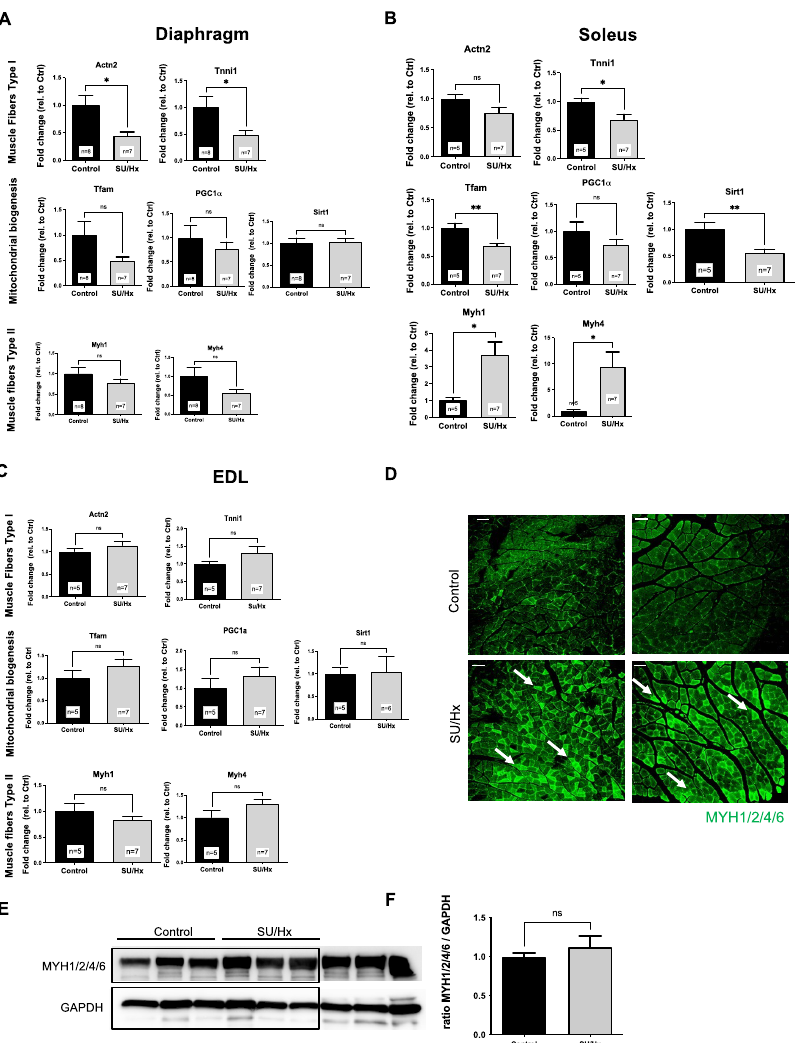
Figure 2. ( A ) Decreased abundance of Type I markers ( Actn2 and Tnni1 ) and markers of mitochondrial biogenesis ( Tfam and PGC-1 α ) in diaphragms from animals with SU/Hx-induced PH when compared to those of the controls. ( B ) Decreased abundance of Type I markers ( Actn2 and Tnni1 ) and markers of mitochondrial biogenesis ( Tfam, PGC- 1α, SIRT -1 ) and increased abundance of Type II markers ( Myh1 and Myh4 ) in soleus muscles from animals with SU/Hx-induced PH when com- pared to those of the controls. ( C ) No difference in abundance of Type I markers ( Actn2 and Tnni1 ), markers of mitochondrial biogenesis ( Tfam, PGC- 1α, SIRT -1 ), and Type II markers ( Myh1 and Myh4 ) in EDL muscles from animals with SU/Hx-induced PH when compared to those of the controls. Expression is normalized to Nup133. Values are expressed as the mean ± SEM. Statistical analysis is conducted by a Student’s t -test, * p < 0.05, ** p < 0.01, ns: not significant.( D ) In the soleus muscle from the control animals, there is less than 1% type II muscle fibers as compared to the 25% proportion that is seen when it was stained with Myh1/2/4/6 (arrows) in the soleus muscle from animals with SU/Hx-induced PH. Immunofluorescence microscopy of soleus cross sections from experimental animals ( n = 3 animals per group). Scale bar, 100 μm. ( E ) Abundance of the Type II markers MYH1/2/4/6 in soleus from SU/Hx animals when compared to that of the controls. Immunoblot with GAPDH are used as a loading control and ( F ) quantitative analysis of MYH1/2/4/6 protein ( n = 9 animals per group). Values are expressed as the mean ± SEM. Statistical analysis is conducted by a Student’s t-test, ns: not significant.